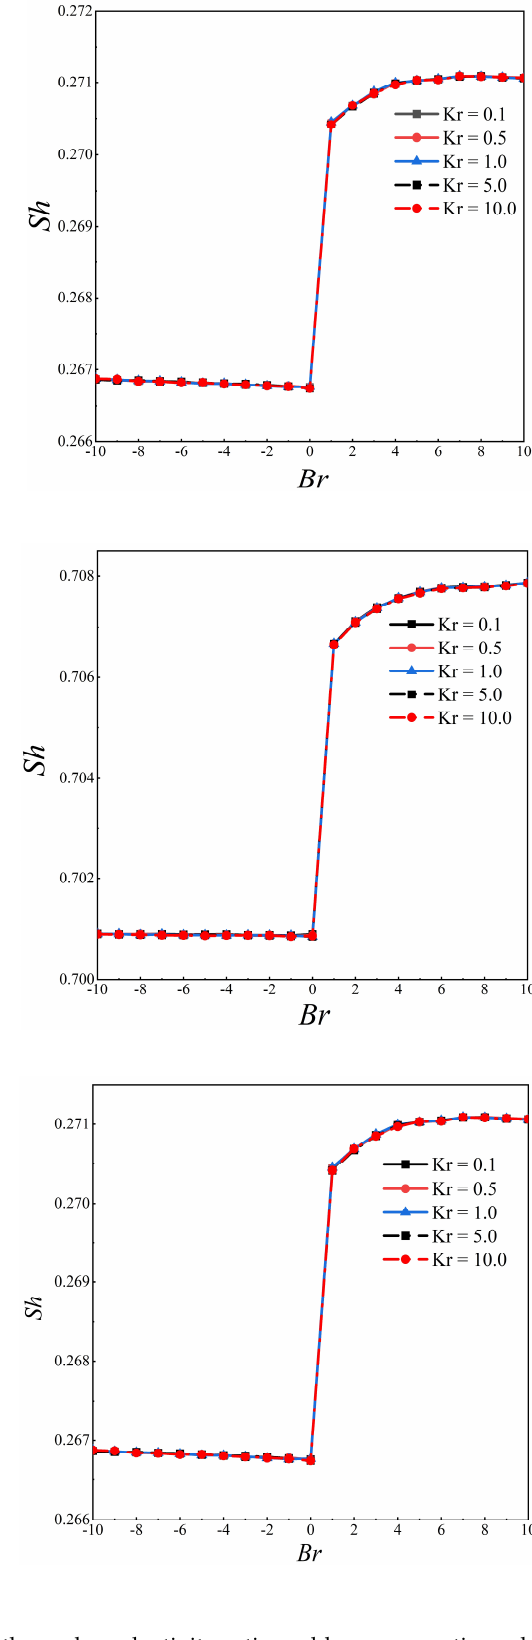
Figure 7. The effect of porous ‐ fluid mass conductivity ratio and buoyancy ratio on heat and mois ‐ ture transfer for three types of porous media arrangement at Ri = 1, Kr = 1, and Da = 10 − 3 . ( a ) Type A, ( b ) Type B, and ( c ) Type C.